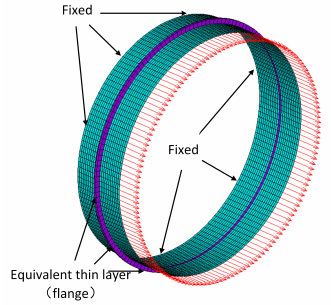
Figure 5. Forced response analysis model of Figure 4 shown in ANSYS.